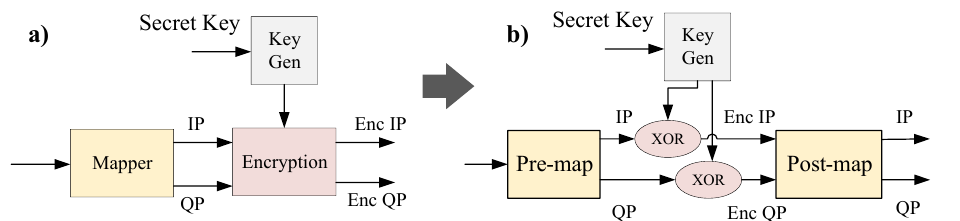
Figure 3. ( a ) Conventional Physical layer encryption (PLE) and ( b ) the proposed joint encryption- modulation (JEM) method.